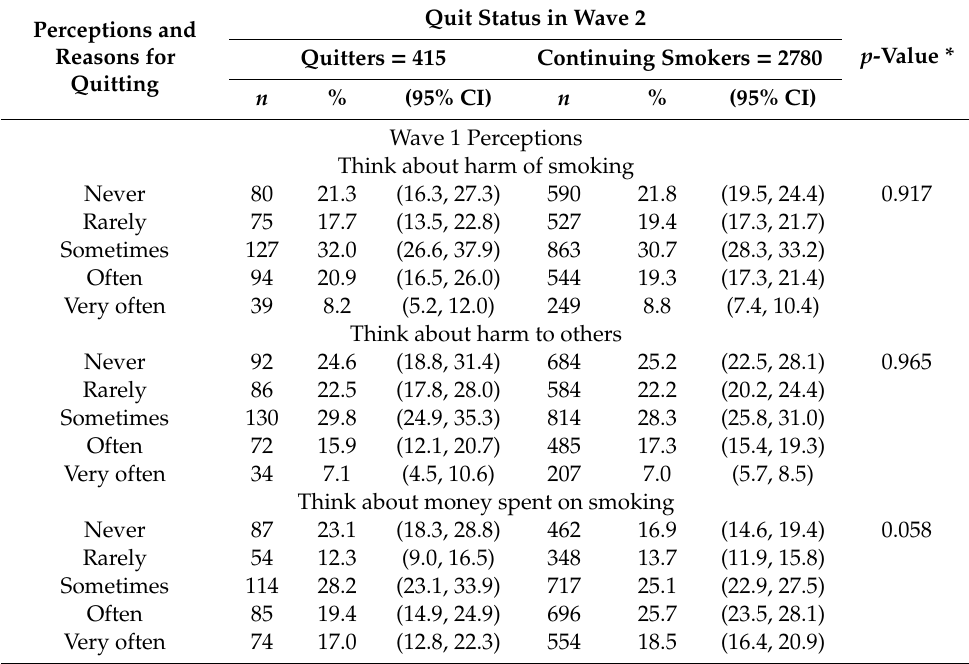
Table 2. Perceptions and reasons for quitting of the cohort sample ( n = 3195) of EUREST-PLUS ITC 6E Survey at Wave 1 (2016) and quit status at Wave 2